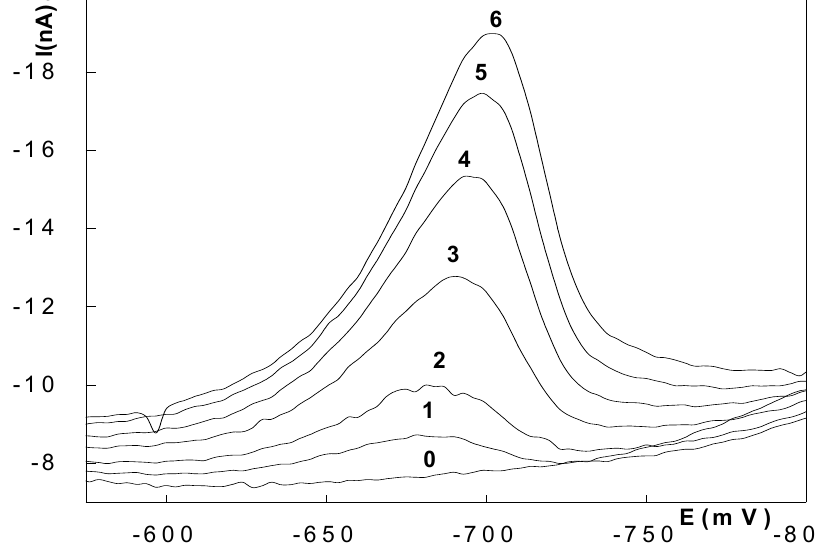
Figure 7. Differential pulse voltammograms of Ostazine Orange at m-AgSAE in 0.01 mol L -1 NaOH. c (Ostazine orange) [µmol L -1 ]: (0) 0 (base electrolyte), (1) 1, (2) 2, (3) 4, (4) 6, (5) 8, (6)10. Potentials for regeneration E = -350 mV, E = -1600 mV. in fin